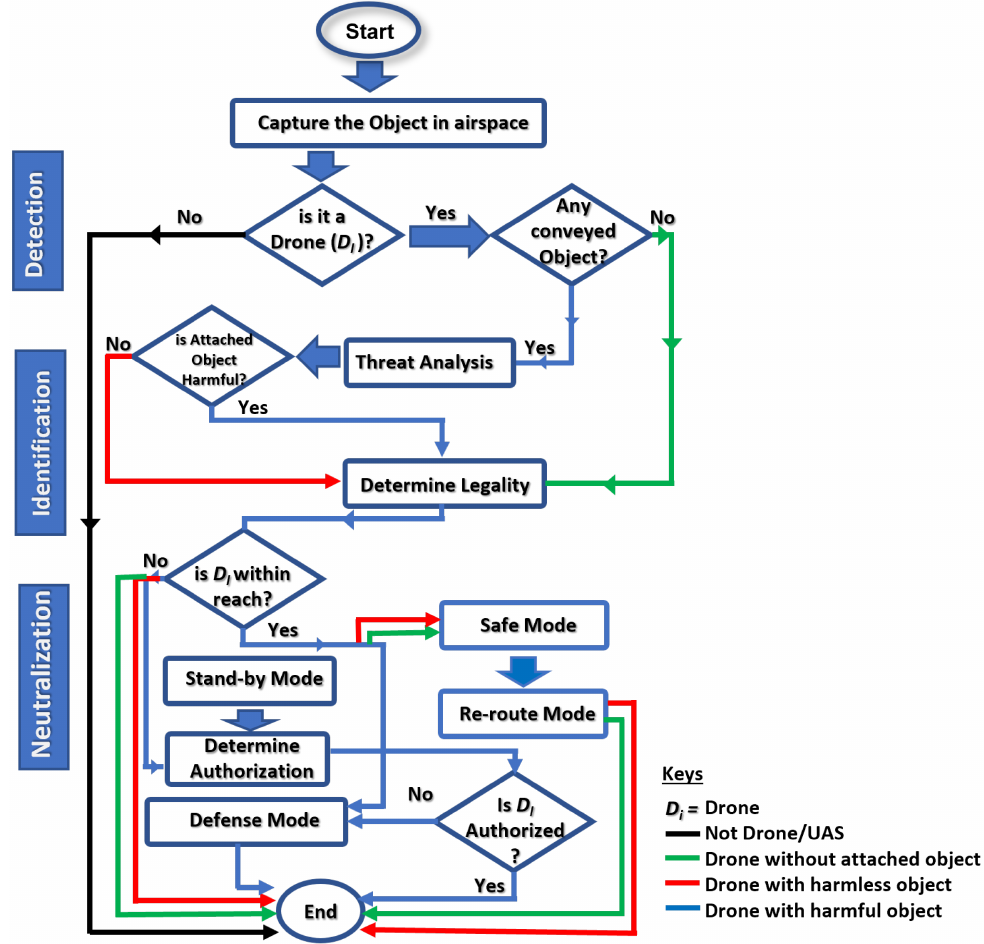
Figure 2. System flow of ALIEN procedure to cooperative counter-invasion in